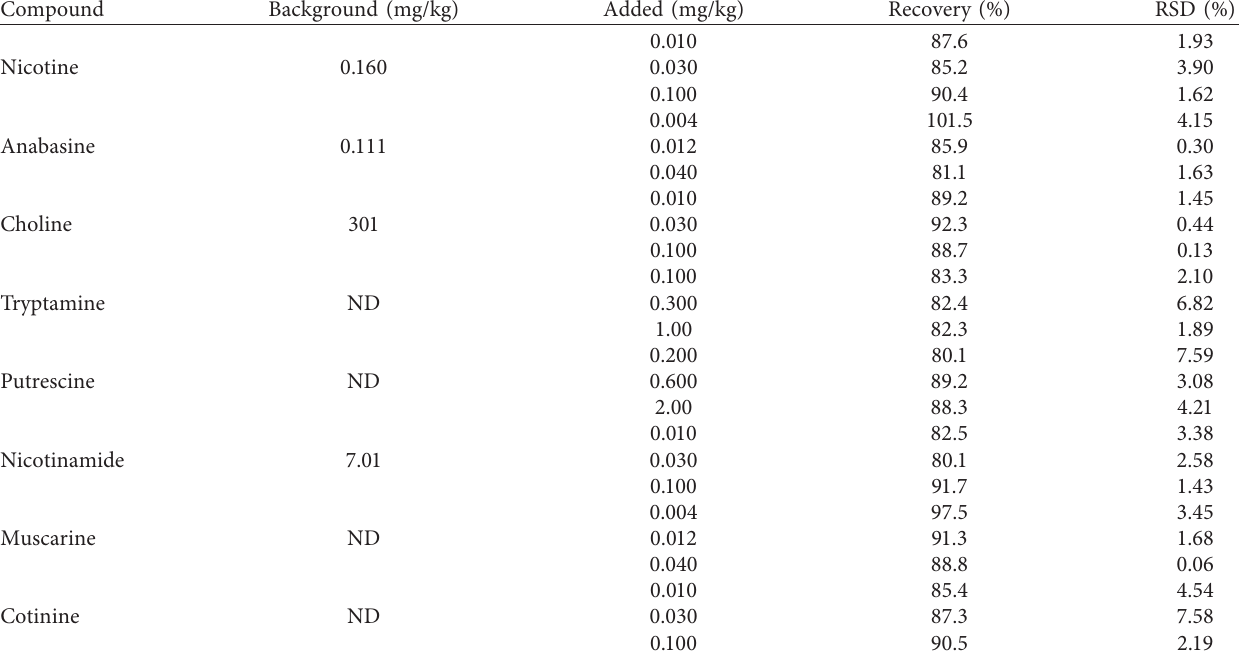
Table 3: Linearity, LODs, and LOQs of the 8 endogenous alkaloids.